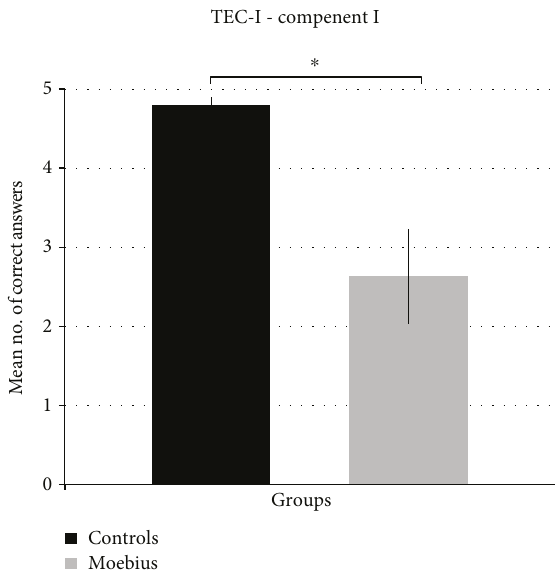
Figure 5: Mean number of correct answers from both control and Moebius participants. During the emotion recognition task ( TEC-1 ), control participants performed better than Moebius participants. Means and standard errors (SE) are reported for both control and Moebius